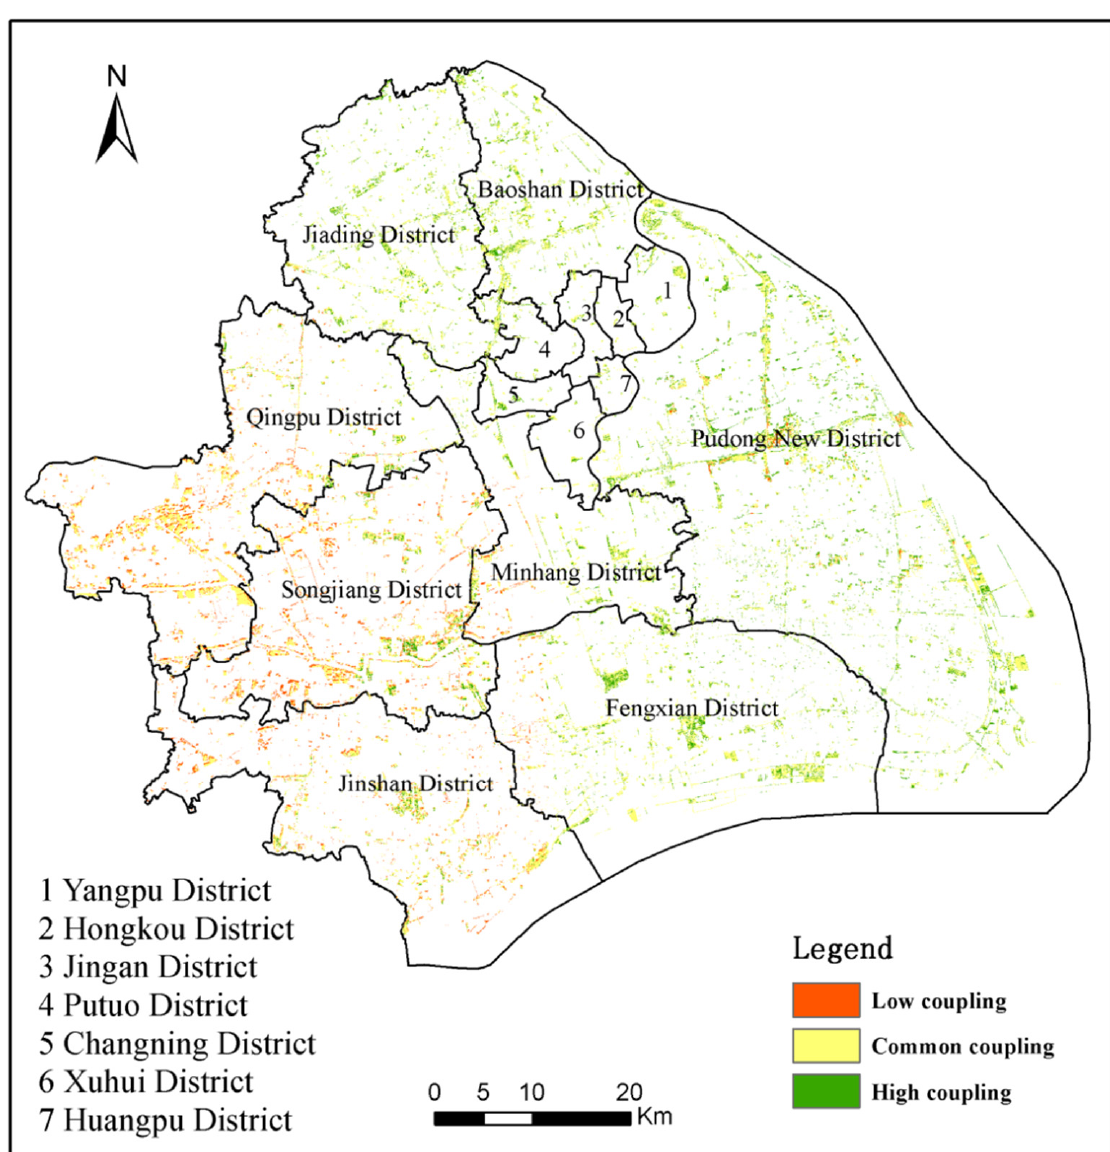
Figure 8. Coupling degrees between PM 2.5 removal capacity and human population in Shanghai.